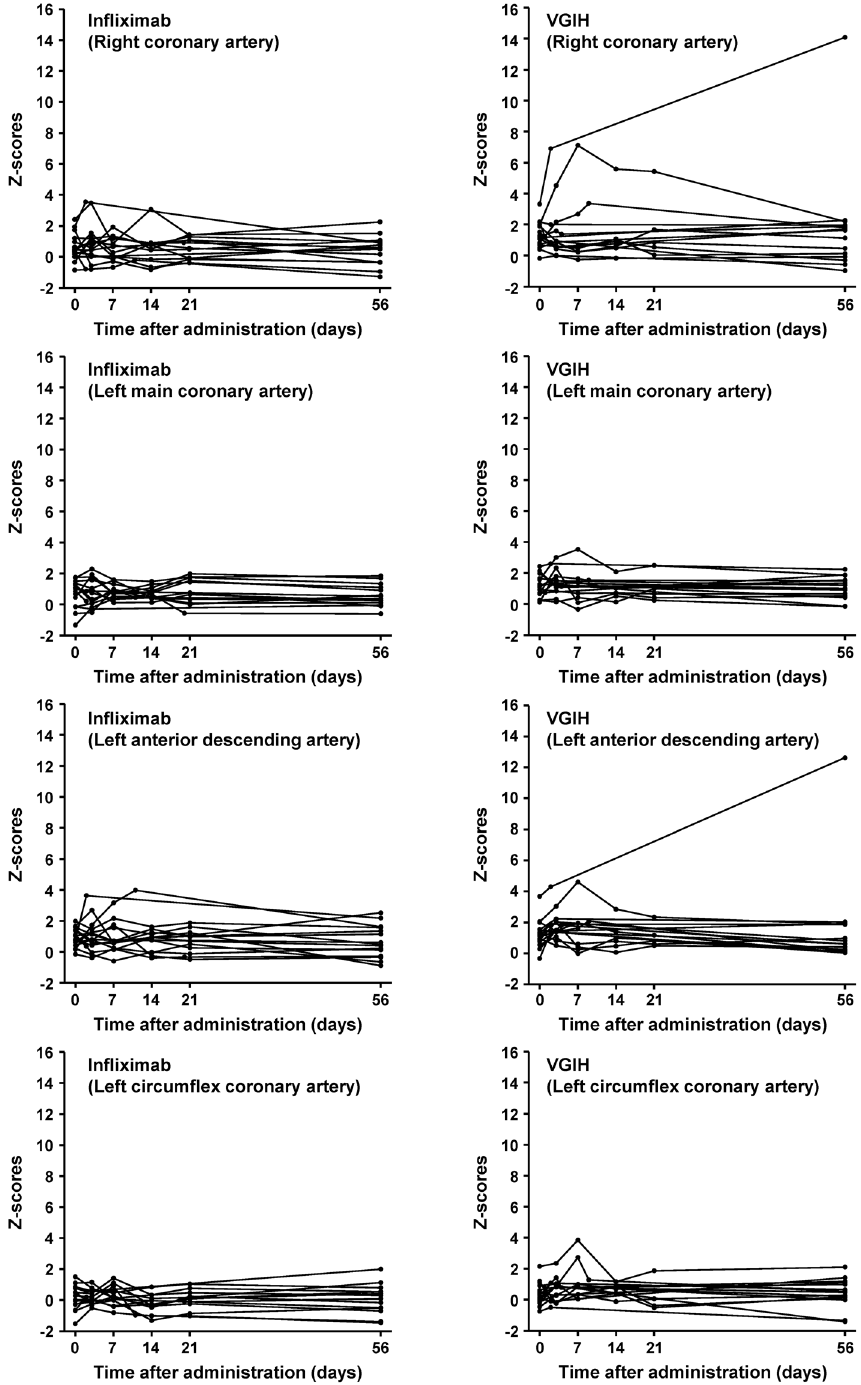
Figure 3. Changes in Z-scores for the internal diameter of the right coronary artery, left main coronary artery, left anterior descending artery, and left circumflex coronary artery in individual patients in each treatment group. VGIH, polyethylene glycol-treated human